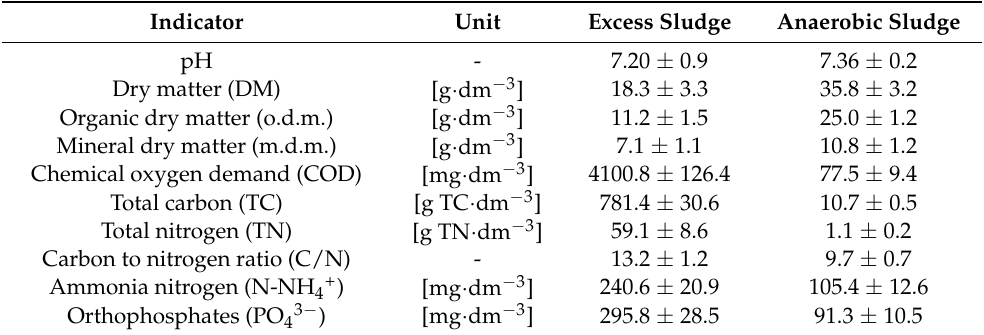
Table 1. Characteristics of dairy sewage sludge (DSS) and anaerobic sludge used as the inoculum in the